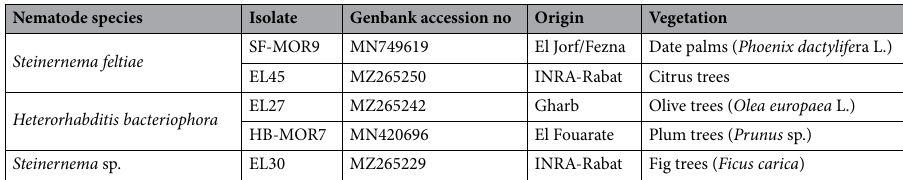
Table 1. Native EPN strains of different species accessions used against Meloidogyne javanica under greenhouse